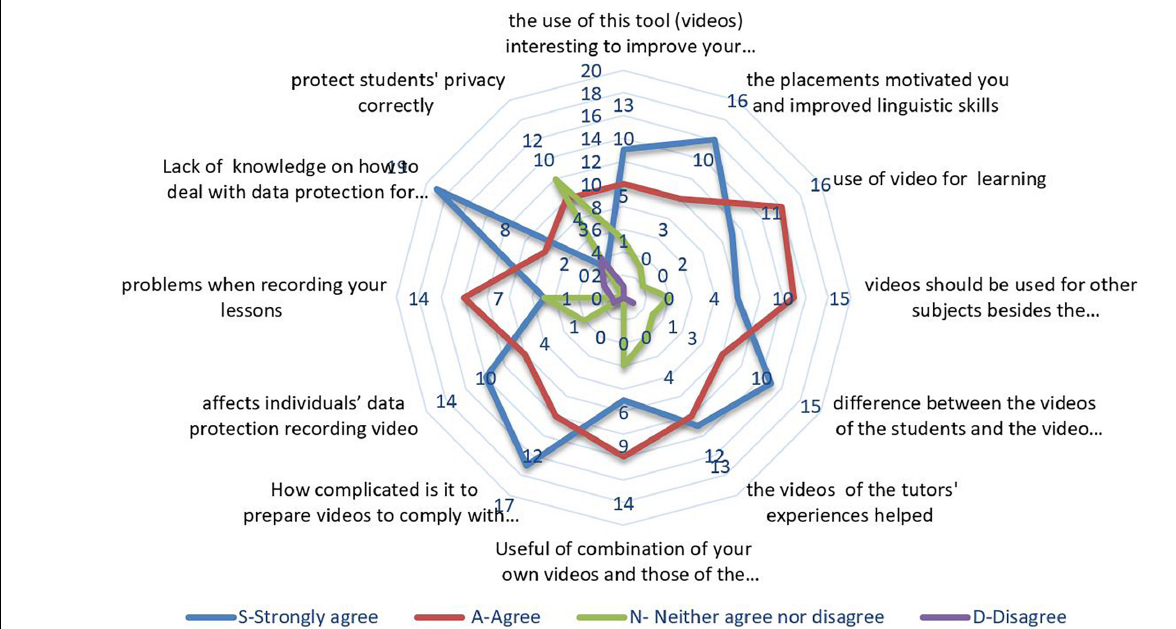
FIGURE 4 | Survey results by questions.